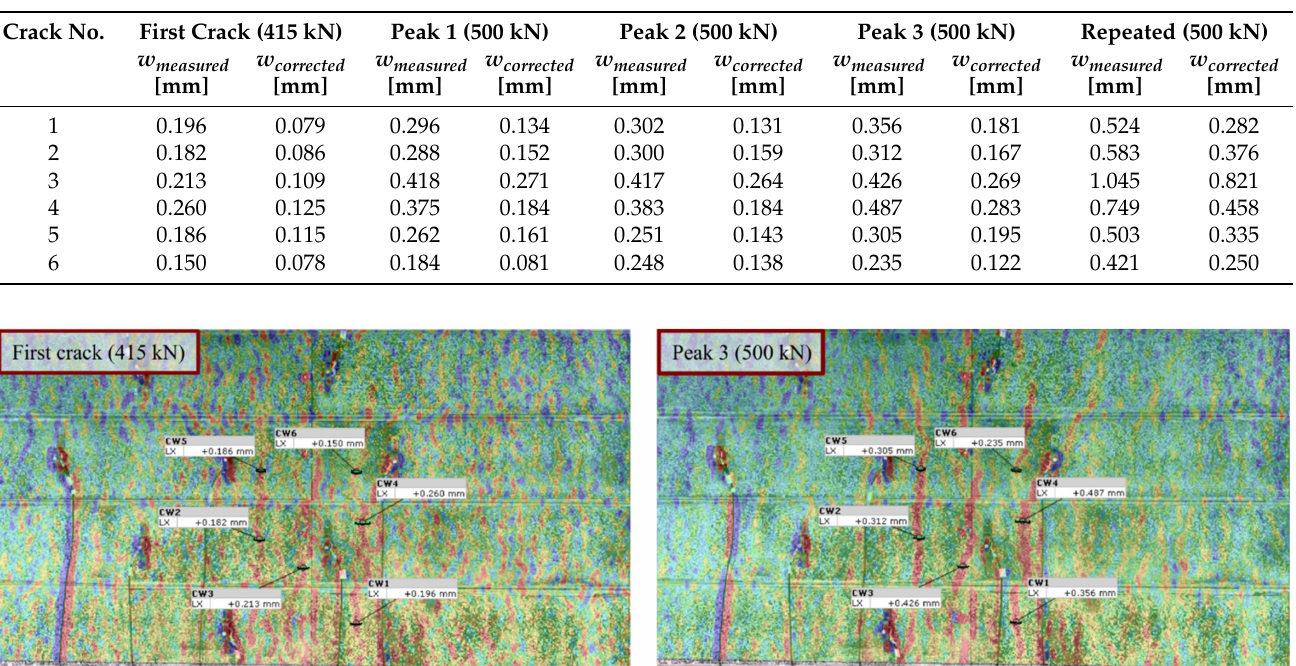
Table 3. Measured and corrected crack widths for three primary cracks on crack detection and all three load peaks of the 500 kN load cycles.